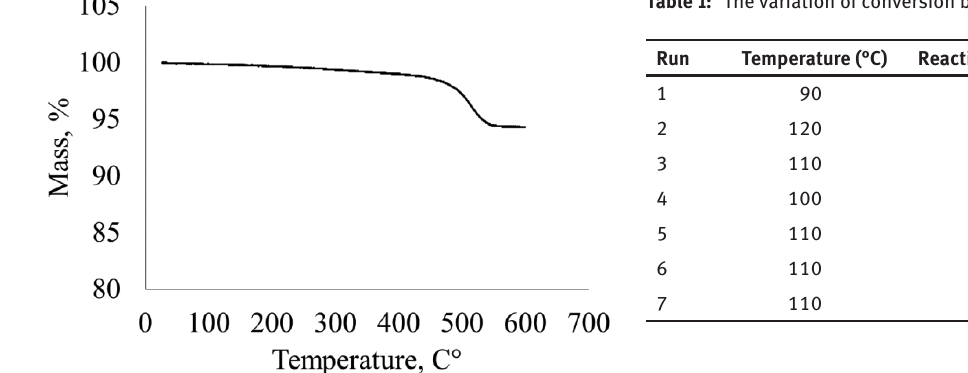
Table 1: The variation of conversion by reaction conditions